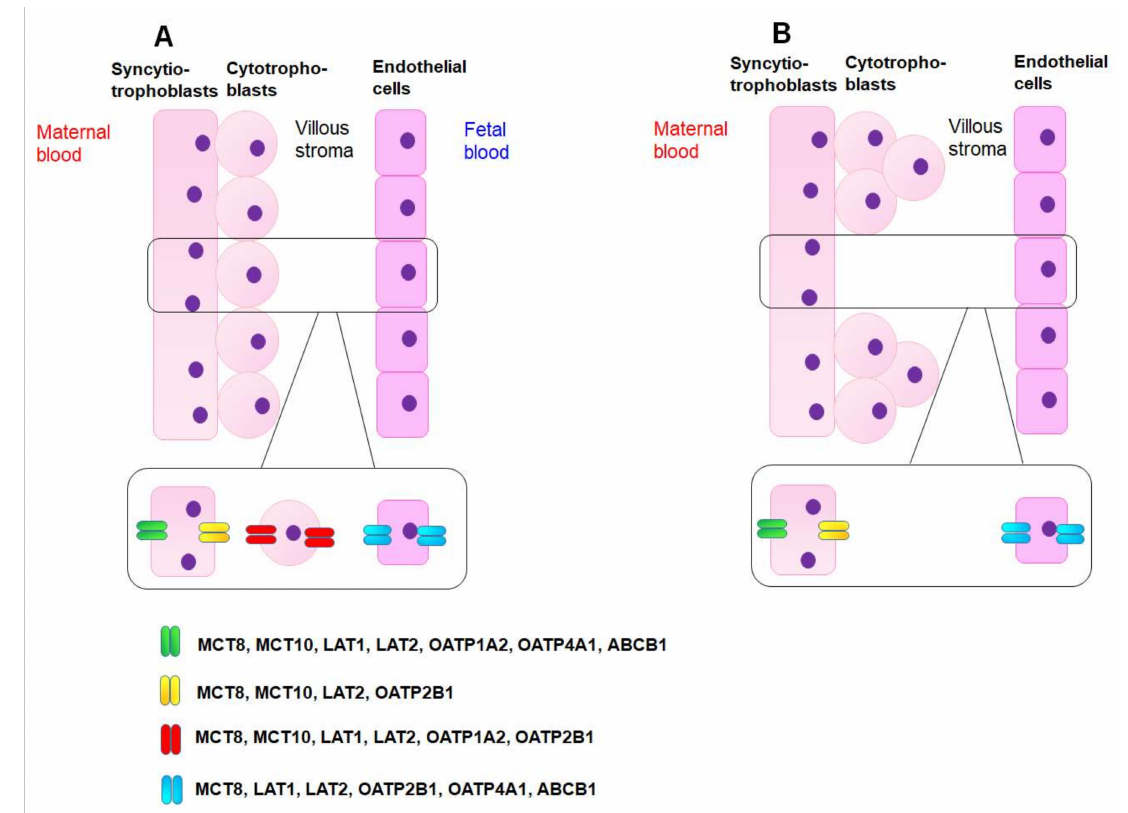
Figure 2. Expression and localization of thyroid hormone transporters in the human placental barrier. A schematic representation of human placental chorionic villi during the first trimester of pregnancy ( A ) and at term ( B ) is depicted. ( A ) During the first trimester, the mononucleated cytotrophoblasts (CTB) proliferate and differentiate into multi-nucleated syncytiotrophoblasts (STB). Both trophoblasts participate in maternal–fetal exchange. As the pregnancy progresses, the CTB gradually forms column structure beneath the STB, leaving the STB primarily controlling maternal– fetal exchange from midgestation. The expression and localization of thyroid hormone transporters are depicted based on the immunostaining studies and single-cell RNA sequencing data mentioned in the text. MCT: monocarboxylate transporter; LAT: L-type amino acid transporter; OATP: organic anion transporting peptide; ABC: adenosine triphosphate binding